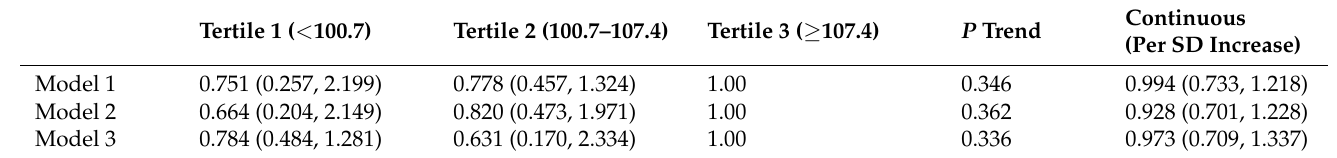
Table 3. Associations of GNRI scores with risk of depression in patients after acute ischemic stroke. Tertile 1 ( < 100.7)